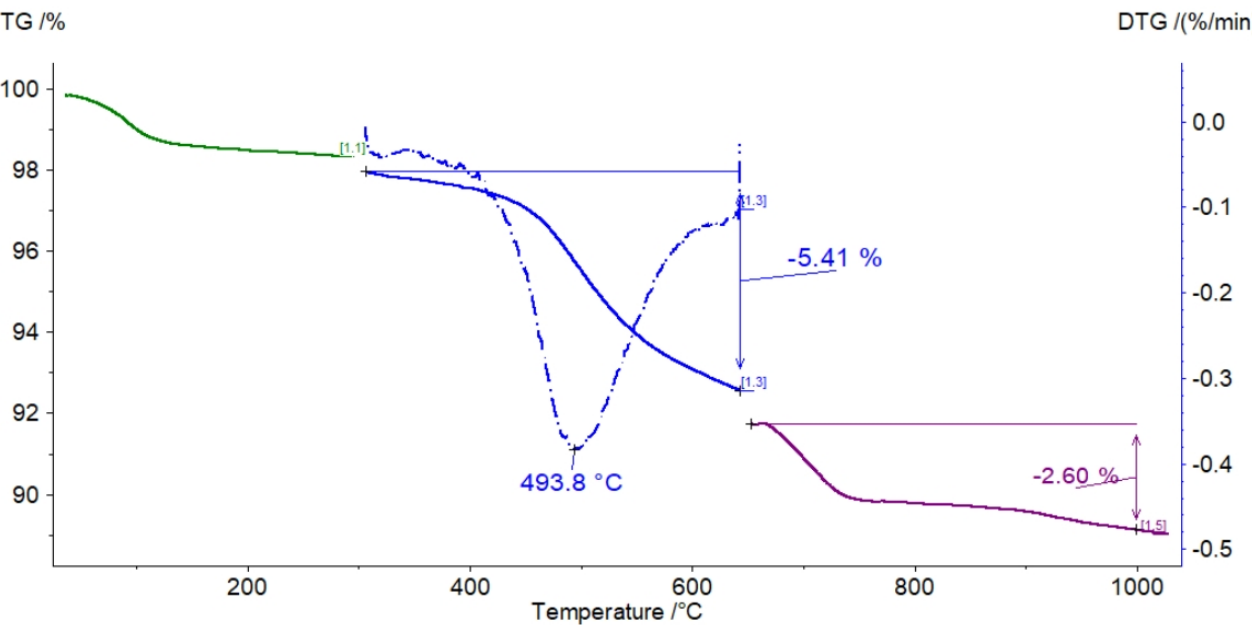
Figure 4. An example of the thermogravimetric analysis in non-isothermal intervals (Sample 8c from the Istebna Beds). The solid line shows the mass loss (TG). The dashed line shows the DTG in the range of 300–650 °C. All samples representing the Istebna layers show a single-staged decomposition process from 300 to 650 °C. The temperature at which the mass is lost at the fastest rate (T TG ) for rock samples belonging to the Istebna Beds was from 493.8 to 529.7 °C. In the case of menilite rock samples, the maximum mass loss temperature (T TG ) was from 428.4 to 538.9 °C. This is a very wide range, indicating the varied thermal maturity of menilite shales. In addition, in the case of this group of rocks, the decomposition of the sample is not always single-staged, as in the case of rocks from the Istebna layers. An example comparison of the course of two-staged pyrolysis (for sample 5) and single-staged (for sample 7) is shown in Figure 5.